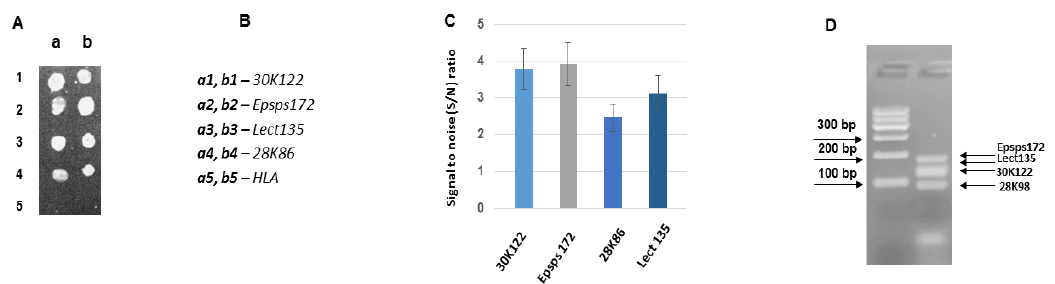
Figure 6. Hybridization of asymmetric multiplex PCR (N2) products with the probes Lect135, epsps172, 28K86 and 30K122 on a biochip. ( A ) Hybridization image ( a , b ) designations of the columns for the probe arrangement; ( B ) The arrangement of the probes on the biochips; ( C ) Analysis of hybridization; the hybridization signal intensities estimated as signal to noise (S/N) ratio. ( D ) Agarose gel electrophoresis of asymmetric PCR products. Total DNA per hybridization is 858 ng, the amount of fluorescent dye Cy3 is 12 pmol.